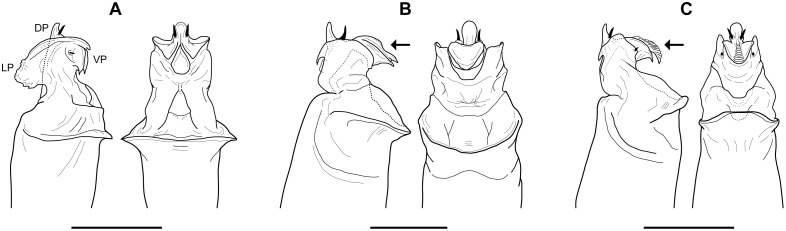
Comparative penis morphology for Sclerobunus species groups.A) cavicolens group - lateral and ventral views, S. ungulatus (Model Cave, NV). B) nondimorphicus group - lateral and ventral views, S. idahoensis (Meadow Creek, ID), arrow indicates smooth dorsal surface of the ventral plate. C) robustus group - lateral and ventral views, S. robustus (Chiricahua Mountains, AZ), arrow indicates dorsal surface of the ventral plate with many folds. DP = dorsal plate, LP = lateral plates, VP = ventral plate. Scale bars = 0.25 mm.